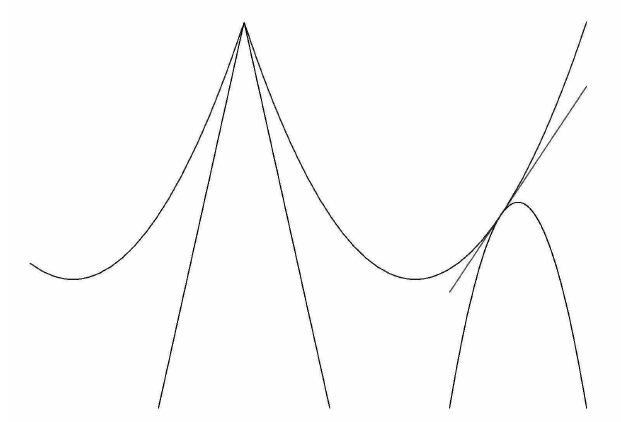
Figure 1. Ekeland (L) and Borwein–Preiss (R) variational